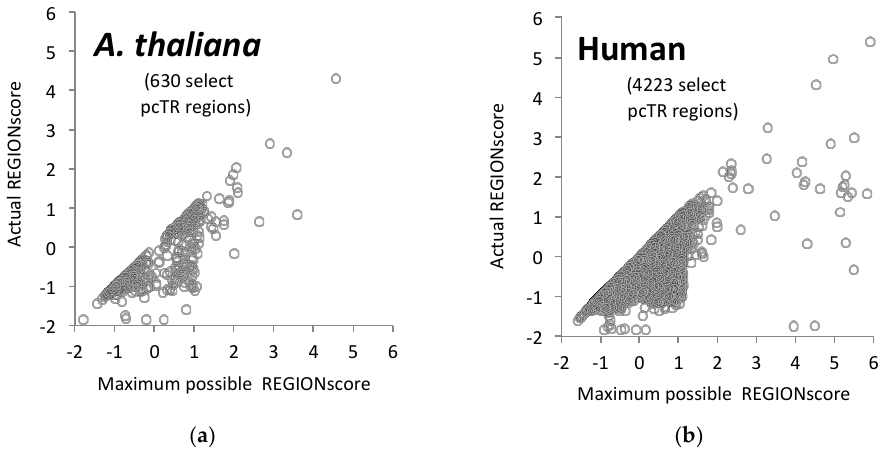
Figure 4. Plot of actual REGIONscores against highest possible REGIONscores for TR regions in ( a ) A. thaliana and ( b ) Homo sapiens. Values for a small selection of pcTR regions are shown. We noticed that in these intron-rich genomes the location of pcTR regions relative to introns may be an additional mechanism for altering their mutation rates. In A. thaliana 50% of genes contained TR regions in their transcribed regions but only 40% of these TR regions were identical to, or contained, TR regions present in the CDS. In the human genome 90% of ORFs we analysed contained TR regions but only 1.6% of these TR regions were identical to, or contained, TR-regions present in the CDS (although this fraction was strongly size-dependent; in CDS’ of 3–6 kb, for instance, 20.1% were not interrupted by introns and in CDS > 400 kb 0.2%).